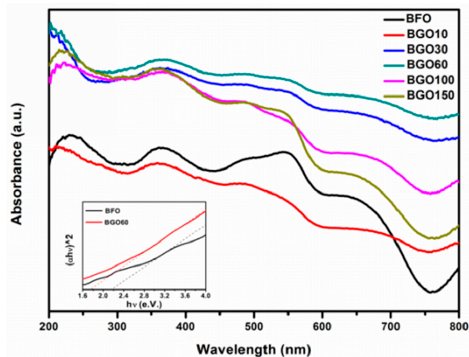
Figure 7. UV-visible absorption spectra of BFO and BGO samples. The inset shows the calculation of band gap.